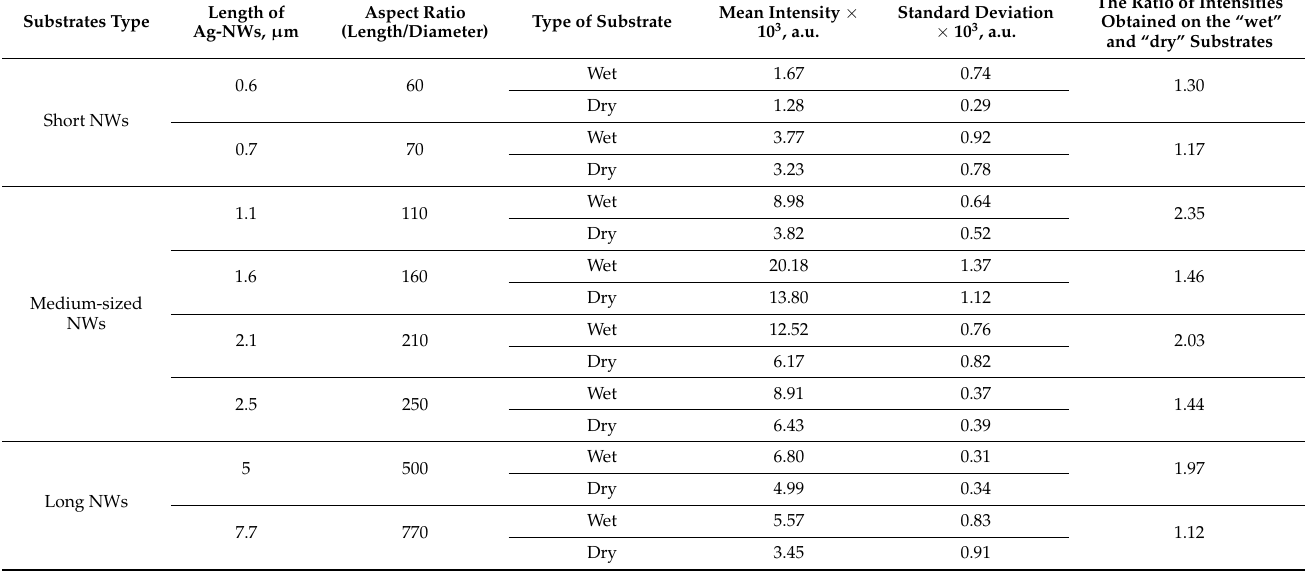
Figure 5. SERS ‐ spectra of 10 μ g/mL 4 ‐ MPBA adsorbed on the “wet” (green dash line) and “dry” Figure 5. SERS-spectra of 10 µ g/mL 4-MPBA adsorbed on the “wet” (green dash line) and “dry” (red dash-dot line) (red dash ‐ dot line) substrates with 1.1 μ m Ag ‐ NWs. For comparison the ordinary Raman spec ‐ substrates with 1.1 µ m Ag-NWs. For comparison the ordinary Raman spectrum of 4-MPBA is shown (blue solid line): trum of 4 ‐ MPBA is shown (blue solid line): brightest Raman spectral peak at ~1600 cm − 1 (in en ‐ brightest Raman spectral peak at ~1600 cm − 1 (in enlarged scale in the dashed circle insert). On the insert chemical structure larged scale in the dashed circle insert). On the insert chemical structure of the analyte molecule is of the analyte molecule is shown. shown. Table 1. Summary of the investigated 4-MPBA intensities adsorbed on different types of substrates differs by Ag-NWs Table 1. Summary of the investigated 4 ‐ MPBA intensities adsorbed on different types of substrates differs by Ag ‐ NWs length collected in 1571 cm − 1 length collected in 1571 cm − 1 .